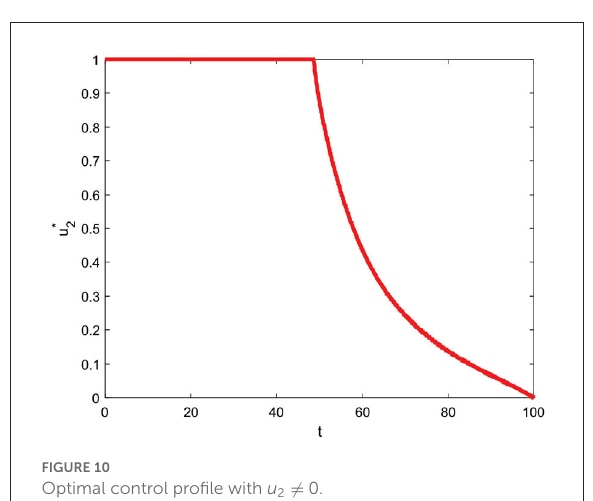
FIGURE10 Optimal control profile with u 2 6= 0.